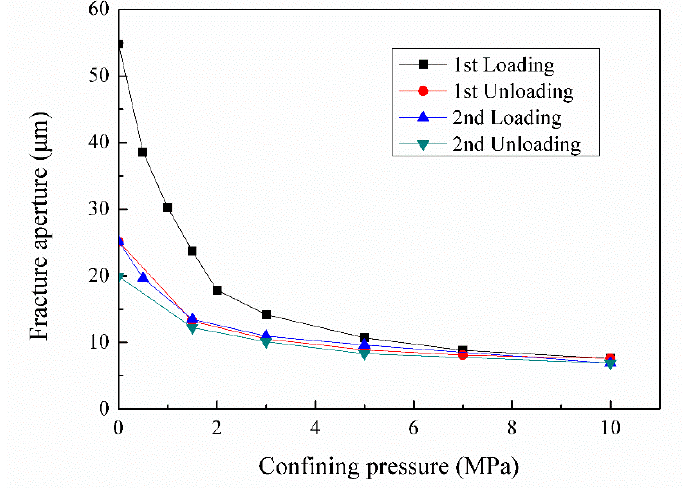
Figure 11. Fracture aperture at a fixed position under different confining pressures of two cycles.